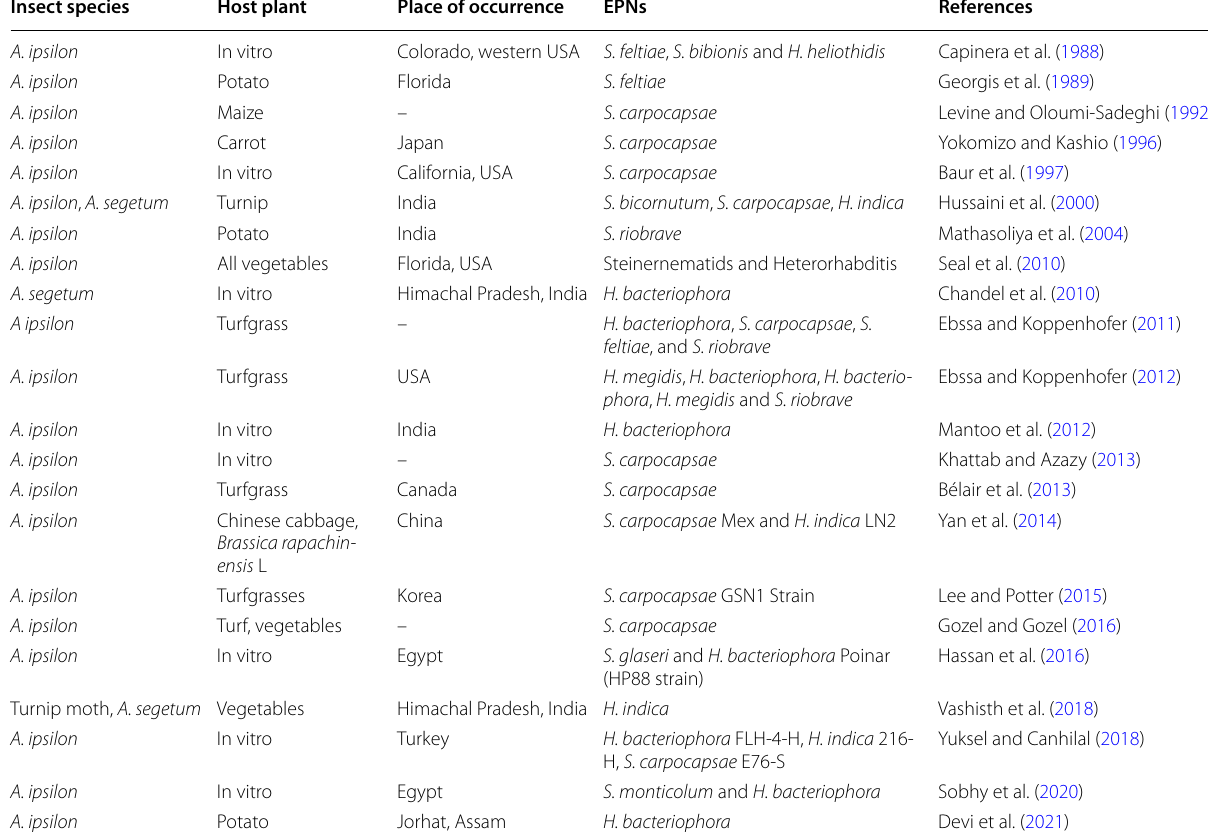
Table 2 Studies on management of Agrotis spp. in India and abroad Insect